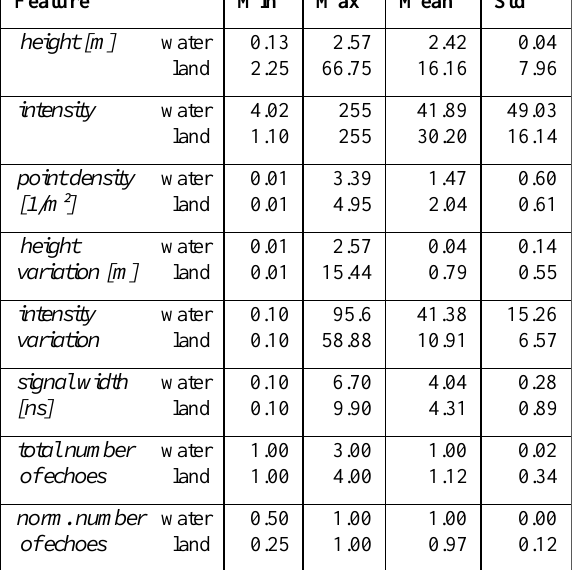
Table 1: Classification features and statistical quantities (minimum, maximum, mean, standard deviation) for water and